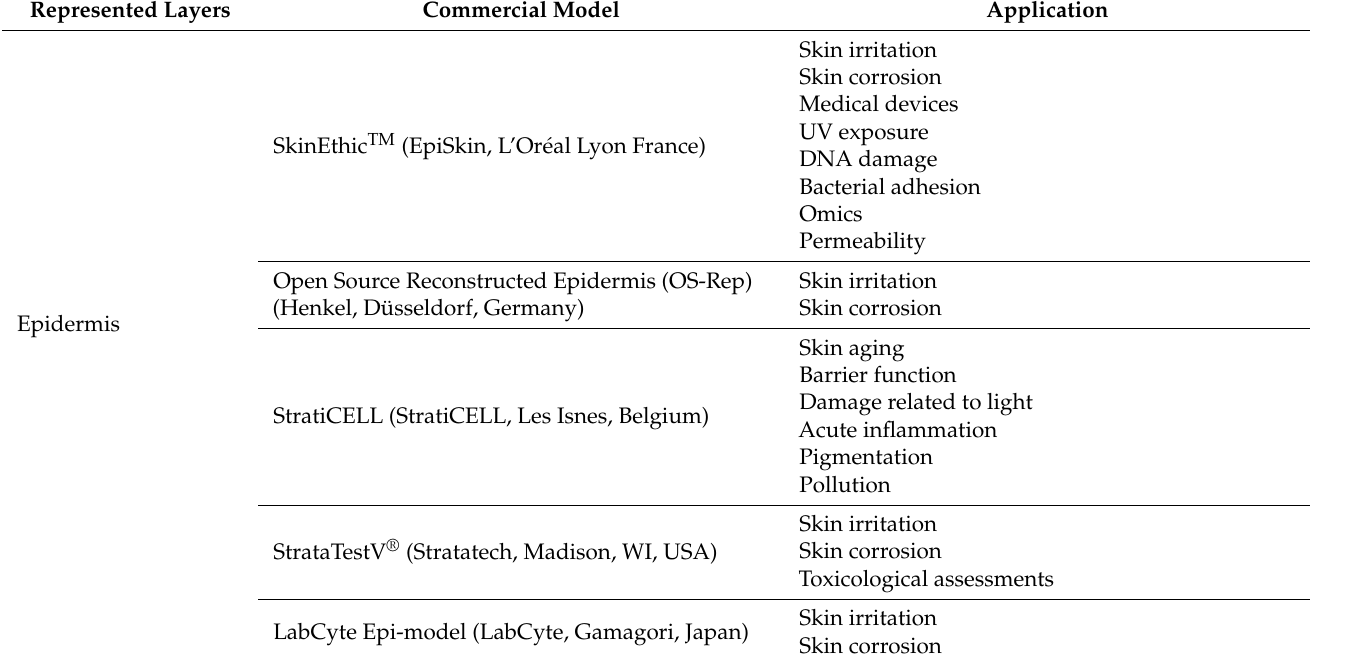
Table 1. Commercial human skin